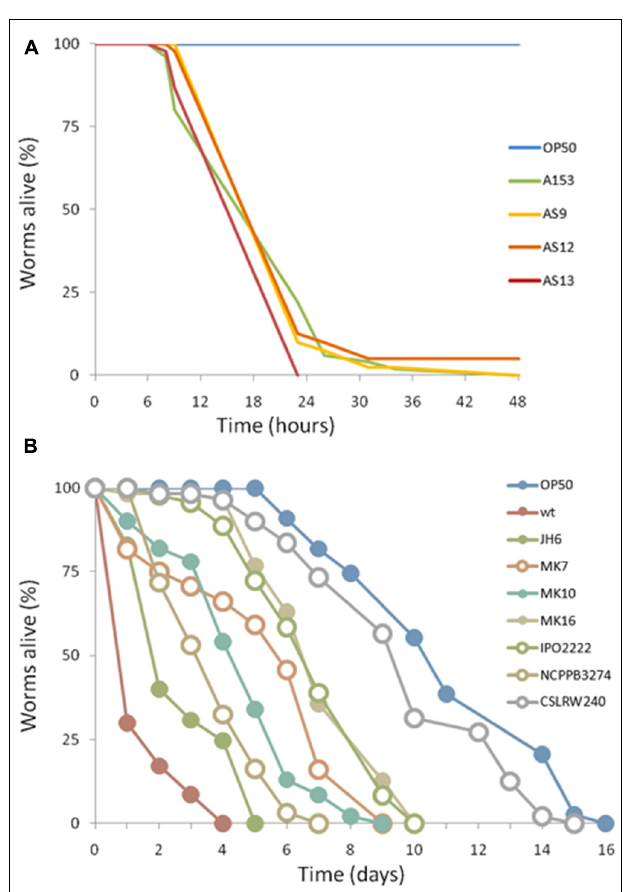
FIGURE 6 |Virulence of enterobacterial strains harboring the zmn gene cluster. The pigmented S. plymuthica strains AS9, AS12 and AS13 show fast killing of C. elegans (A) . In contrast, D. solani strains MK10, MK16, IPO2222 and Dickeya spp. MK7 and NCPPB3274 showed no fast killing of C. elegans (B) . For each experiment, worms were transferred at the L4 stage and the results of a representative trial with at least 50 worms under each condition is shown.